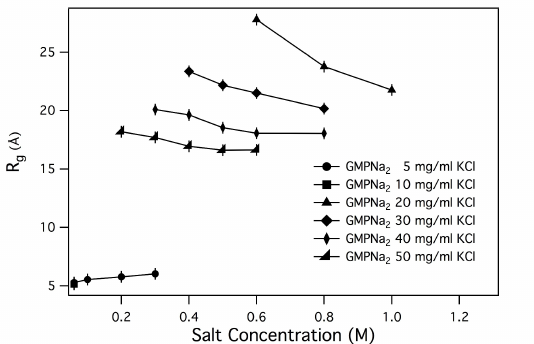
Figure 7. Ionic strength dependence of R g measured from GMPNa 2 samples prepared in KCl. GMPNa 2 concentrations are reported in the legend.